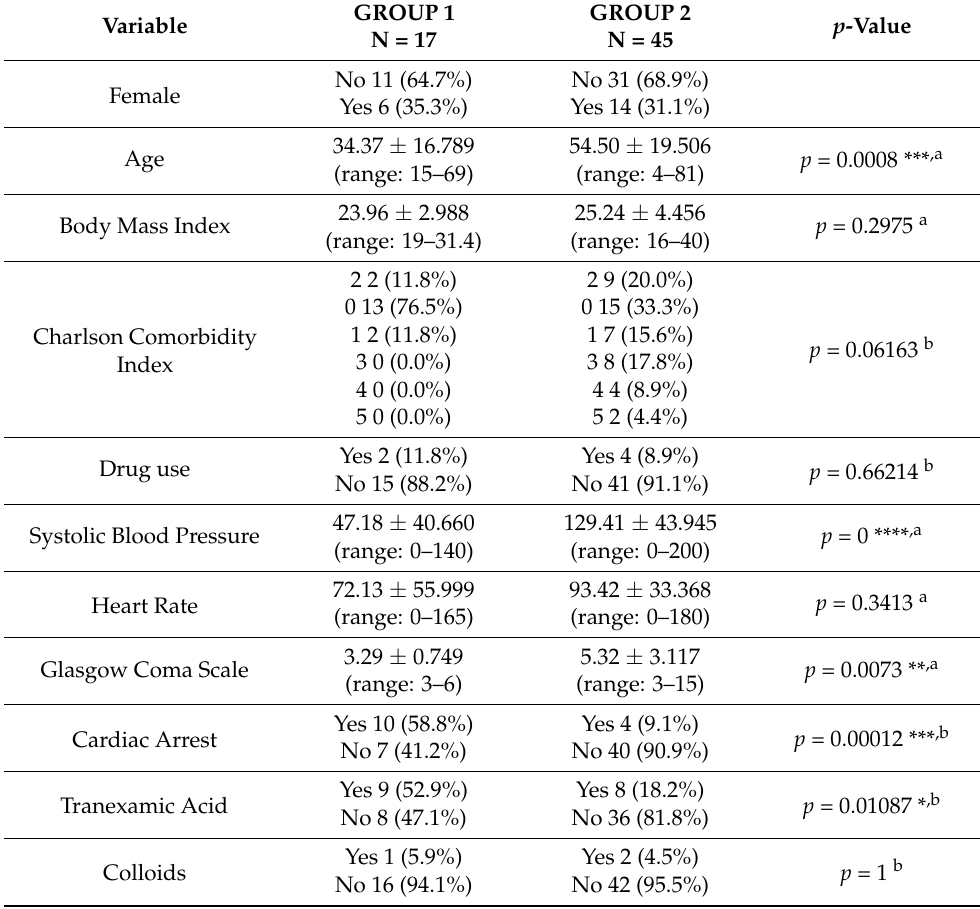
Table A1. Comparison of